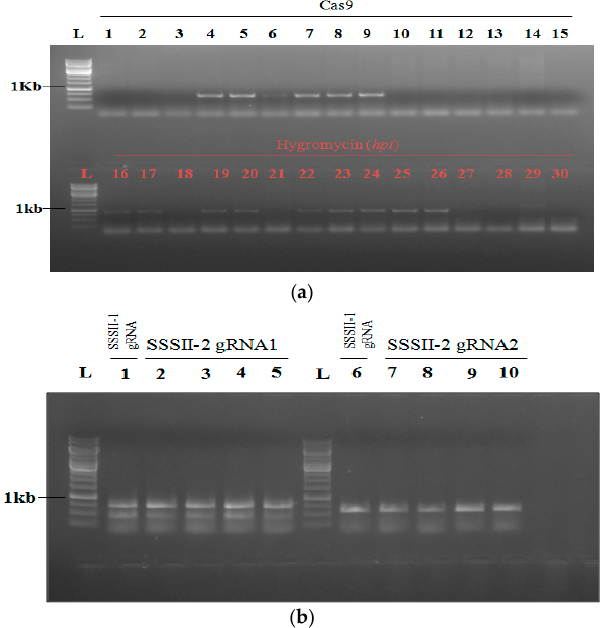
Figure 4. The confirmation of transgenic plant lines in the laboratory using the PCR technique employing isolated DNA from mutant plants of MTU1010 and control plants. L band is 1 kb DNA ladder. ( a ) The confirmation of the Cas9 primers by PCR is shown in the first row of the given gel and in the second row the confirmation of SSSII-1 and SSSII-2 genes is shown in the Agarose gel containing hygromycin. ( b ) Bands 1 and 6 of SSSII-1 genes confirmed with SSSII-1 -targeted sequence of primers, bands 2 to 5 of SSSII-2 gene confirmed with SSSII-2 target 1 sequence primers, and bands 6 to 10 of SSSII-2 gene confirmed with target 2 sequence